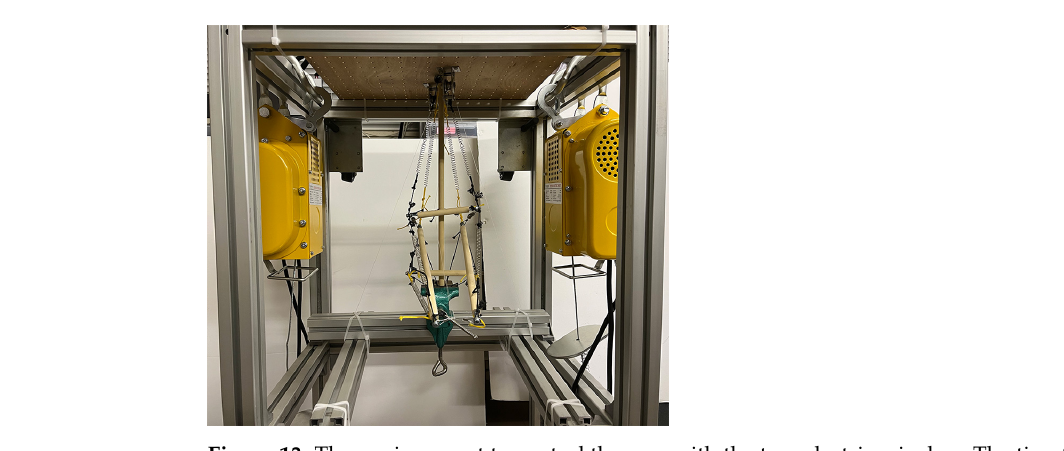
Figure 13. The environment to control the arm with the two electric winches. The tip of the arm can be pulled by an electric winch through the paths of the pulley strings shown in Figures 11 and 12.